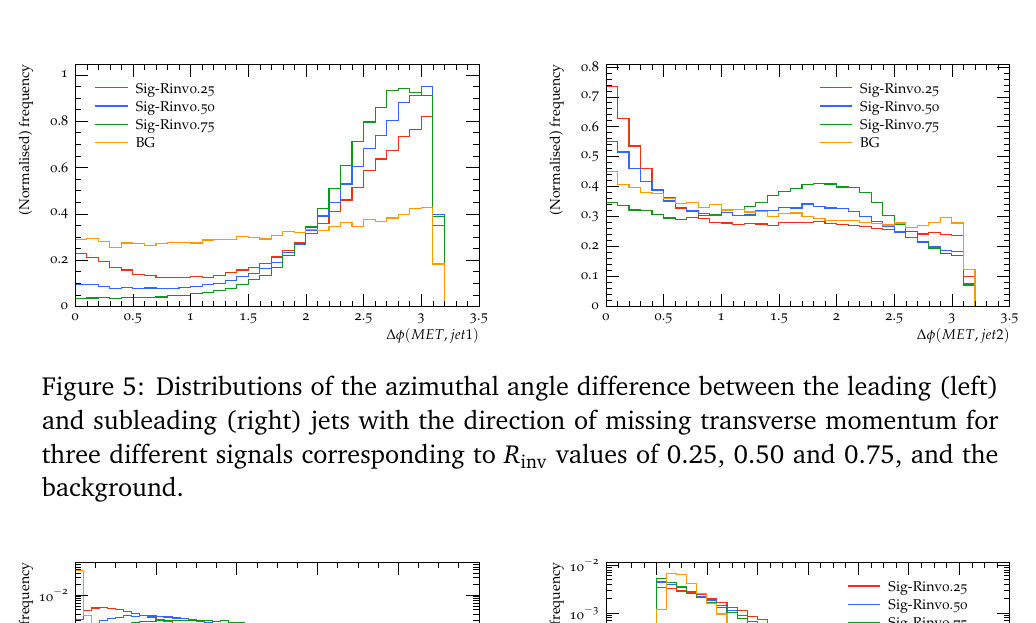
(top left), LHA (top right), τ (bottom left) and τ 2 21 32 values of 0.25, inv = 1 and p = 400 - 600 FSR T